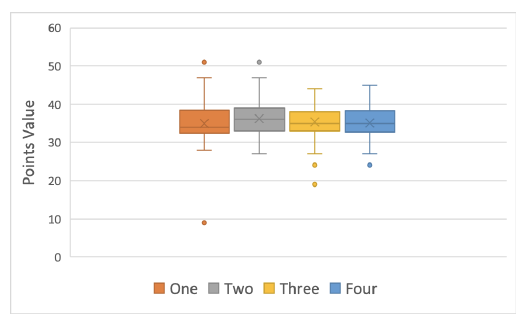
Figure 9. Likelihood of using the password “Password123” and password strength score. In this figure, the bar charts indicate the password score as measured by zxcvbn. The x-axis indicates how likely a participant says they are to use this password – 1 is “not likely” and 5 is “likely”.